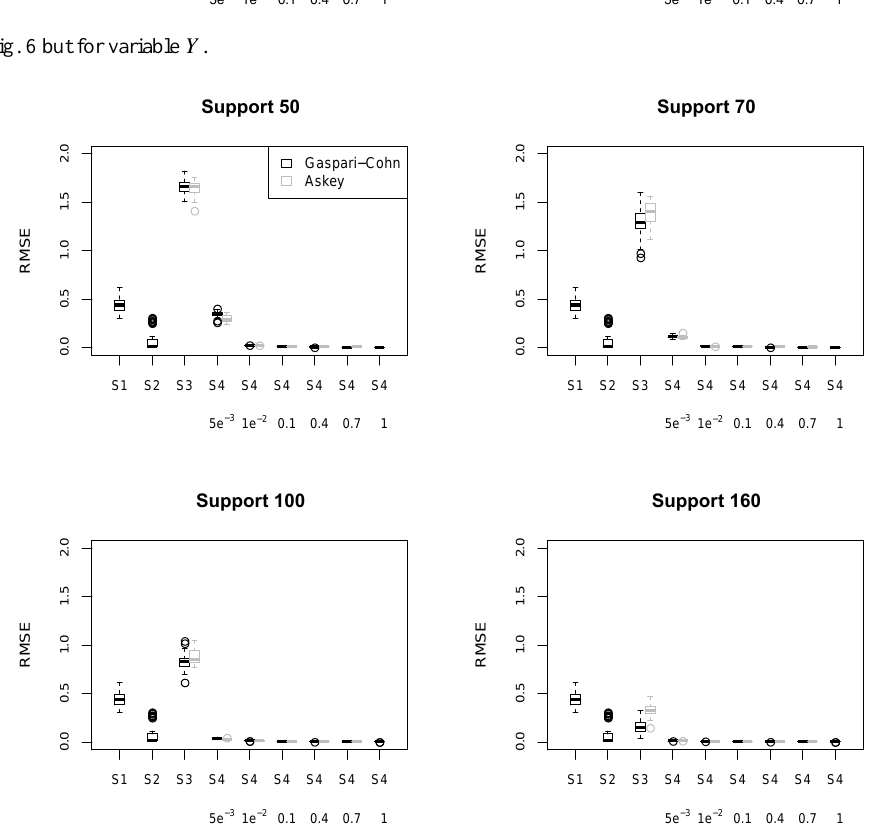
Figure 8. Same as Fig. 4 but for 500 ensemble